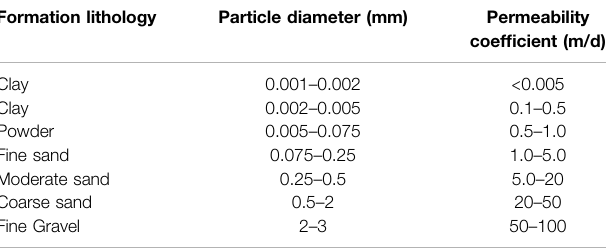
TABLE 1 | Reference values of permeability coef fi cients of different diameter particles. Formation lithology